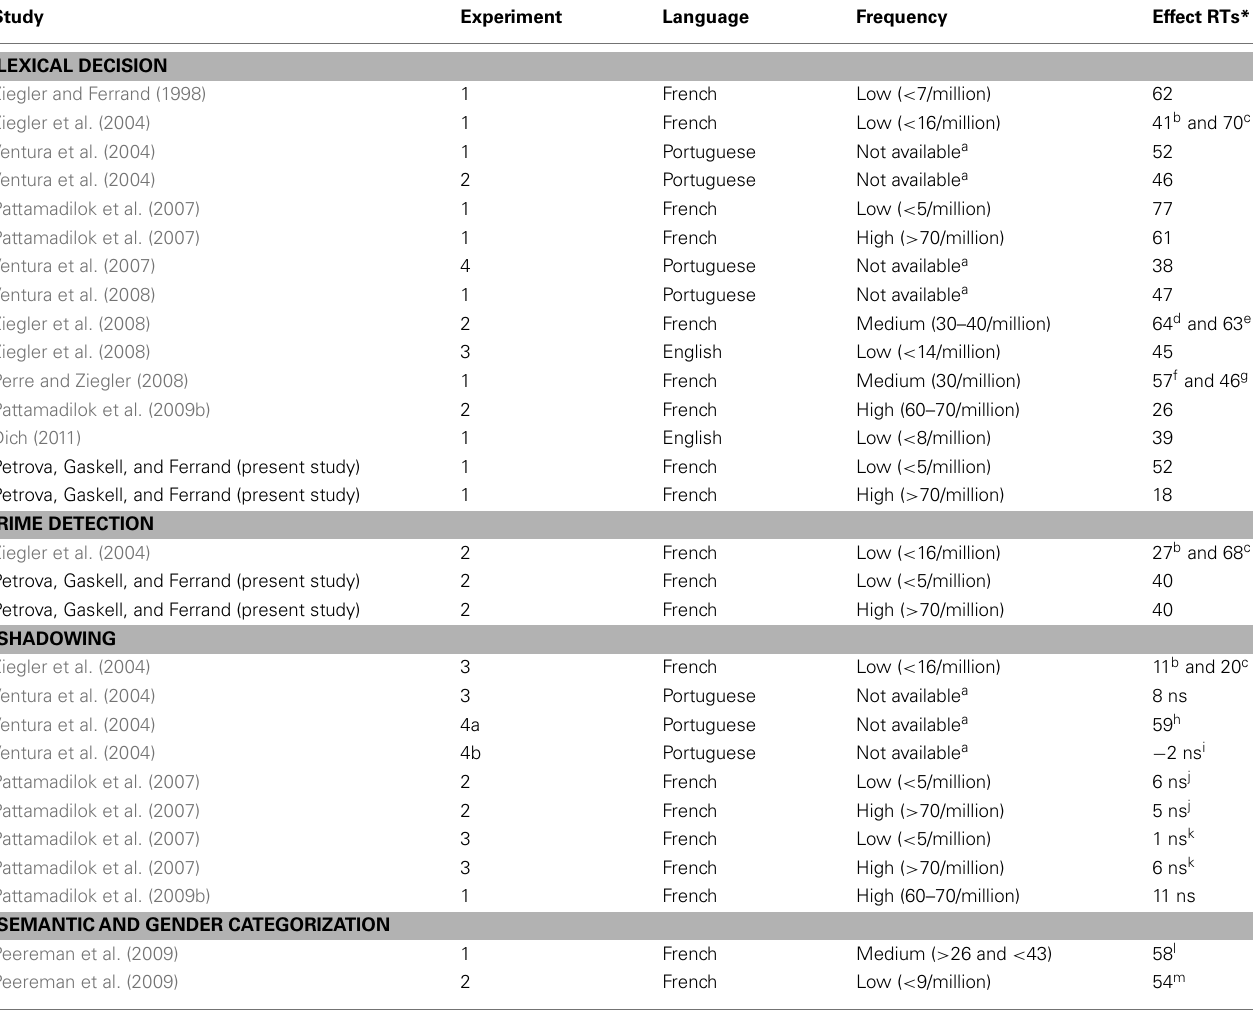
Table 1 | Summary of empirical investigations of orthographic consistency effects on adults with monosyllabic